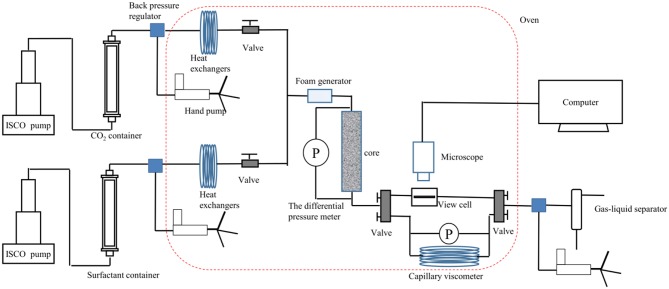
Flow loop apparatus for evaluating SC-CO2 foam apparent viscosity, resistance factor and bubble texture at 70°C and 8 MPa.